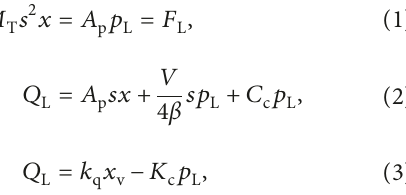
Figure 1: Mechanical model of dual shaking tables with